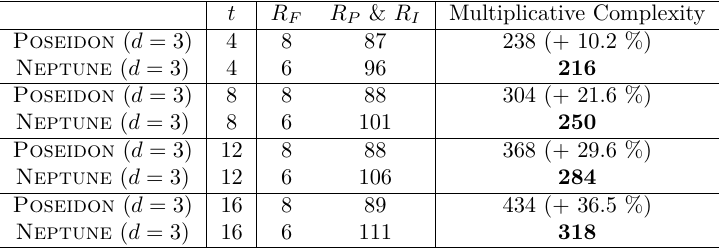
Table 1: Comparison between Poseidon and Neptune – both instantiated with d = 3 – for the case p ≈ 2 256 , κ = 128, and several values of t ∈ { 4 , 8 , 12 , 16 } . t